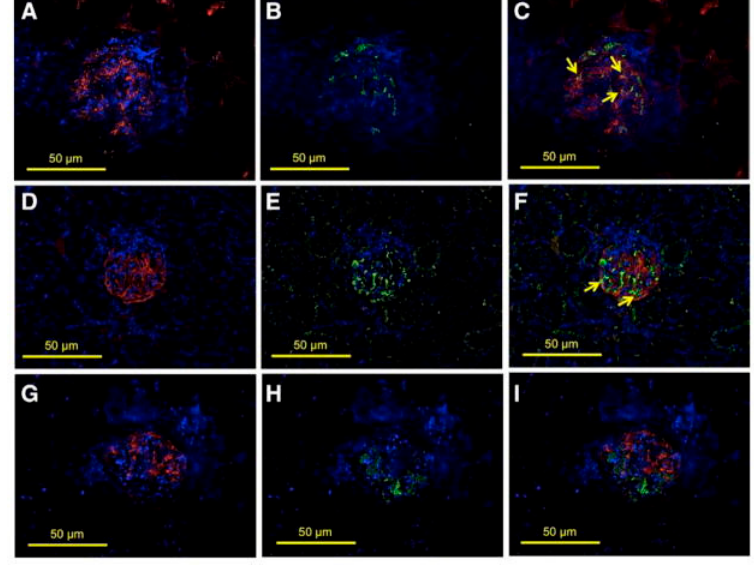
Figure 5. Glomerular expression of transcription factor avian erythroblastosis virus E26 oncogen homolog-1 (ETS-1) in hypertensive Dahl salt-sensitive (DS) rats. Colocalization studies were performed to characterize the expression of ETS-1 in the glomerular endothelium (CD31), podocytes (synaptopodin), or mesangium (desmin). ( A – C ) show positive stain for CD31 ( A , red), ETS-1 ( B , green), and some areas in which there is colocalization of CD31 and ETS-1 indicating endothelial expression of ETS-1 ( C , arrows); ( D – F ) show positive stain for synaptopodin ( D , red), ETS-1 ( E , green), and areas in which there is colocalization of ETS-1 and synaptopodin indicating expression of ETS-1 in podocytes ( F , arrows); ( G – I ) show positive stain for desmin ( G , red), ETS-1 ( H , green); no clear evidence of colocalization of ETS-1 and desmin was observed ( I ), suggesting lack of expression of ETS-1 in mesangial areas (×40 magnification).